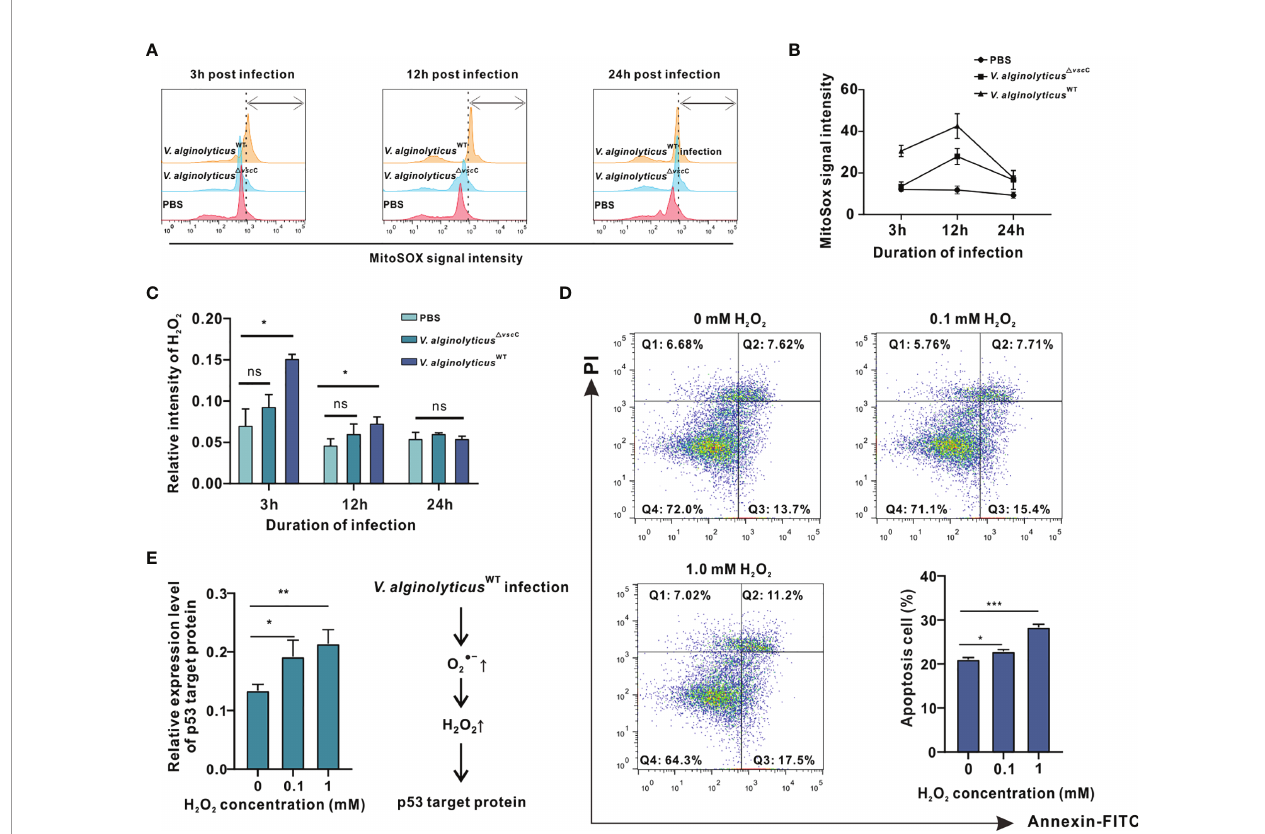
FIGURE 4 | V. alginolyticus WT challenge induced cell apoptosis and activated apoptotic pathway accompanied by intracellular O (cid:129) − 2 and H 2 O 2 production in oyster hemocytes. (A) Time course of O (cid:129) − 2 release in oyster hemocytes at 3, 12, and 24 h after V. alginolyticus △ vscC or V. alginolyticus WT injection, as detected in fl ow cytometry (FACS) analysis with the mitochondrial O (cid:129) − 2 probe MitoSOX. Red color represents the uninfected control injected with PBS; blue color represents the group injected with V. alginolyticus △ vscC ; and yellow color represents the group injected with V. alginolyticus WT . (B) Quanti fi cation of MitoSOX fl uorescence intensities. (C) Time course of H 2 O 2 formation in oyster hemocytes at 3, 12, and 24 h after V. alginolyticus △ vscC or V. alginolyticus WT injection. Data were analyzed by two-way ANOVA and presented as mean ± SEM (n = 3); * p < 0.05; ns, not signi fi cant. (D) Representative dot-plot results in FACS for hemocyte apoptosis following stimulation with exogenously applied H 2 O 2 at the concentrations of 0, 0.5, and 1 mM. Q1: necrotic/non-viable cells; Q2: late apoptosis/secondary necrosis; Q3: early apoptosis; Q4: living cells. Histogram displays the statistical analysis of apoptosis in hemocytes in response to varying levels of H 2 O 2 . Data were analyzed by one-way ANOVA and presented as mean ± SEM (n = 3); * p < 0.05; *** p < 0.001. (E) Relative expression levels of p53 target protein (p53tp) after stimulation by exogenously applied H 2 O 2 at the concentrations of 0, 0.5, and 1 mM. Data were analyzed by one-way ANOVA and presented as mean ± SEM (n=3); * p < 0.05; ** p < 0.01. Right panel displays a presumed respiratory bursts model during hemocyte response to V. alginolyticus △ WT